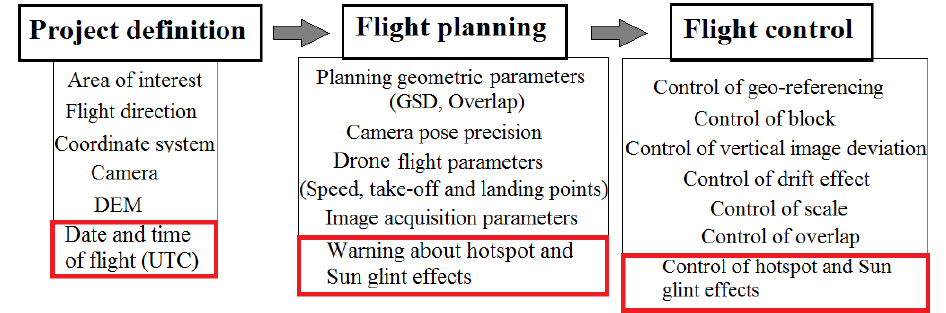
Figure 4. Flowchart for flight planning and control with special attention to hotspot and sun glint effects (highlighted in red colour). The rest of functions in flight planning and control can be analysed in detail in [34].